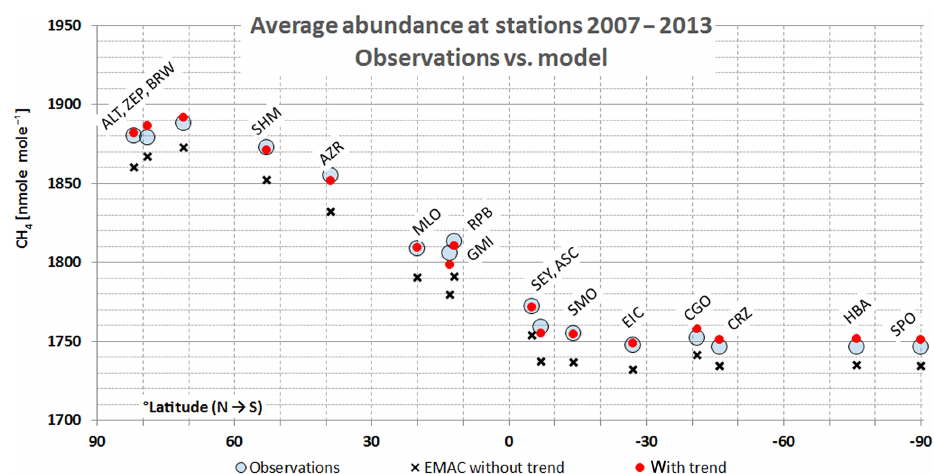
Figure 10. Calculated total CH 4 without (black crosses) and with optimized trend period emissions (red dots). By scaling RIC, SHA, and TRO emission fractions, the station observations (blue circles) are approximated with the smallest RMSD. After 2013, the trend accelerates and additional emission assumptions are necessary.